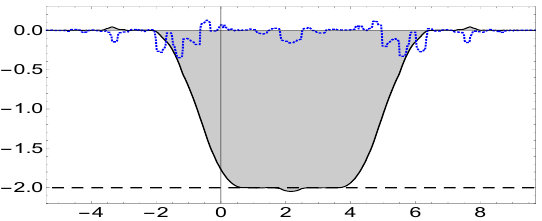
Figure 23. Two kinks and oscillon for l = 4 : 3246 at t = 14 : 272. The dotted line represents derivative of the (cid:12)eld with respect to time @ t (cid:17) .